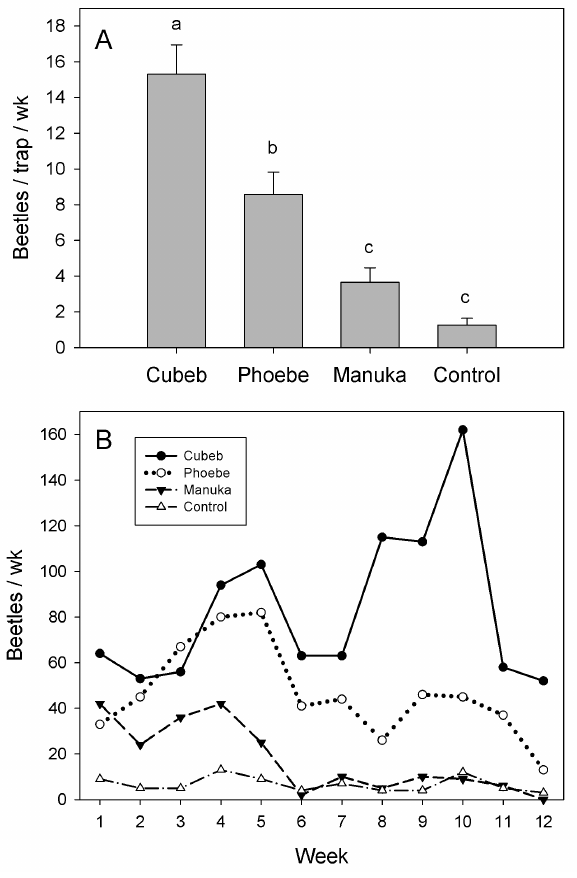
Figure 3: Captures of female Xyleborus glabratus in a 12-wk field test conducted in Highlands County, FL, USA. ( A ) Mean (± SE) captures and ( B ) summed weekly captures obtained with commercial oil lures and an unbaited control; N = 5 traps per treatment. Bars topped with the same letter are not significantly different; adapted from [31].